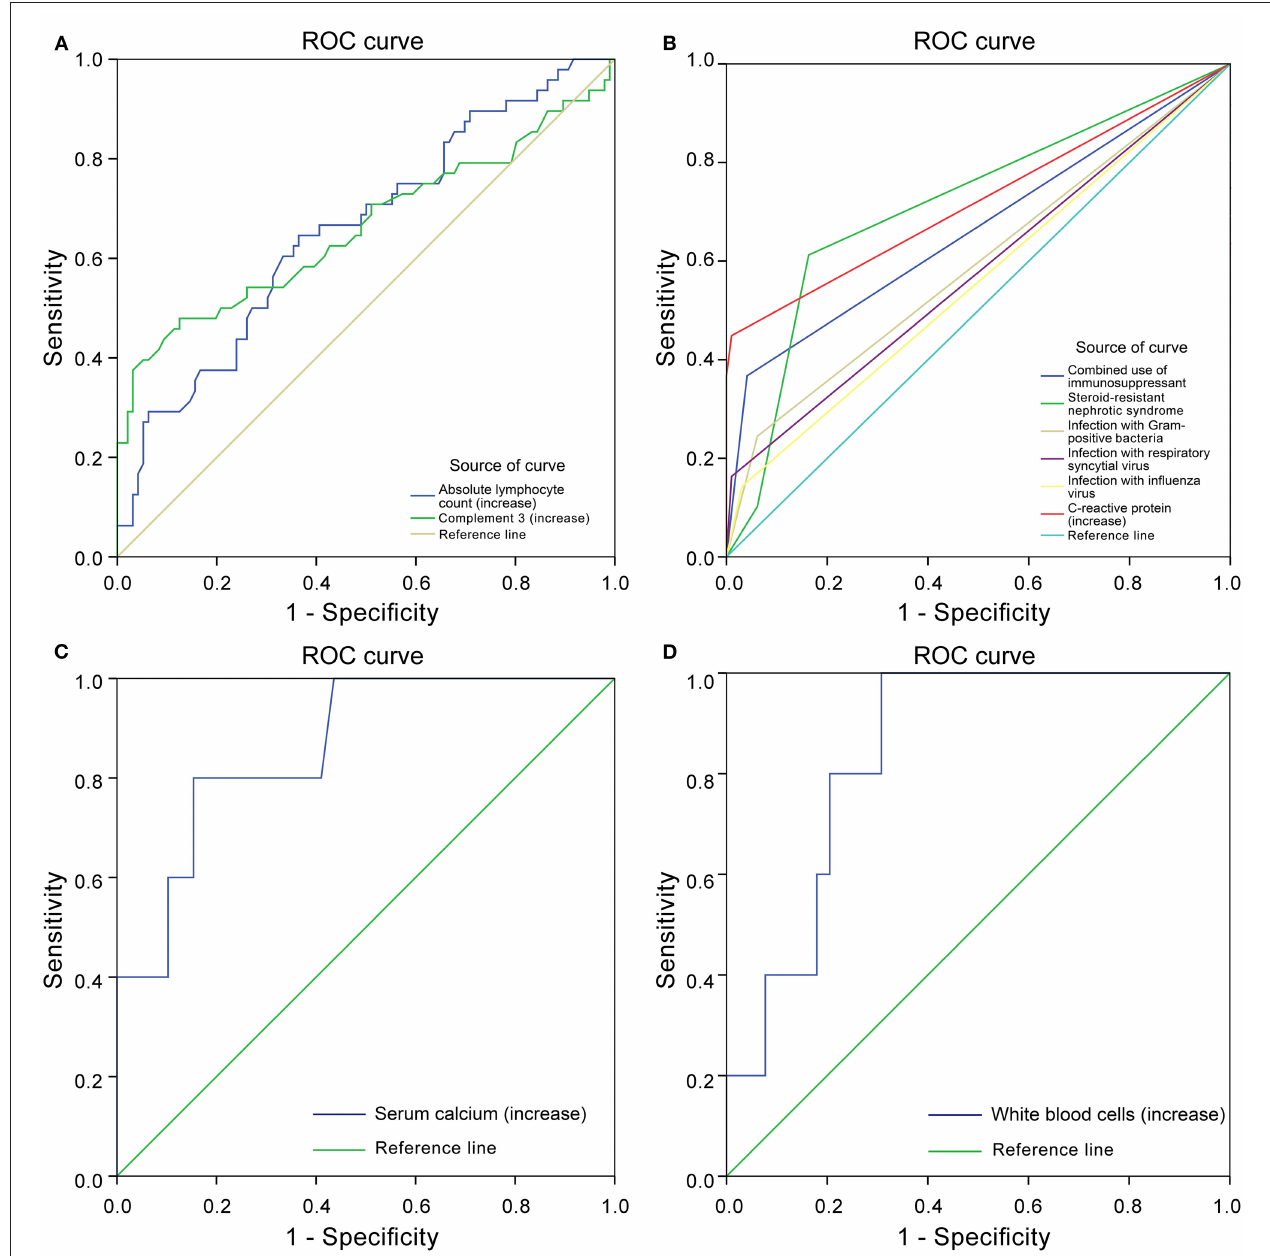
FIGURE 2 | Receiver operating characteristics (ROC) curve. Protective factors of severe infection (A) . Risk factors of severe infection (B) . Protective factors for poor prognosis of severe infection (C) . Risk factors for poor prognosis of severe infection (D) .